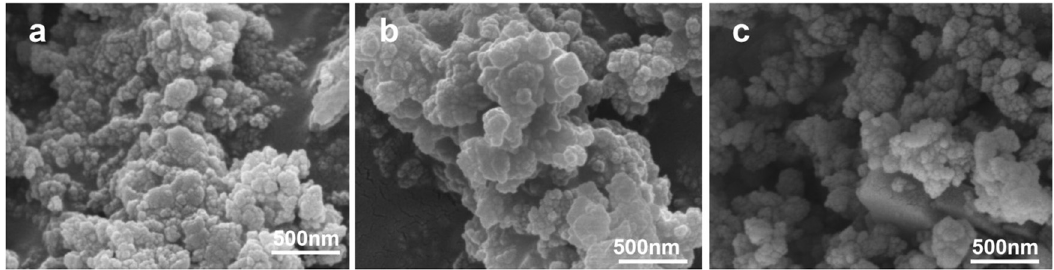
Figure 2: SEM of AlCl 3 /H β catalysts prepared with di ff erent concentrations of AlCl 3 : ( a ) AlCl 3 ( 1 g · L − 1 ) /H β , ( b ) AlCl 3 ( 3 g · L − 1 ) /H β , and ( c ) AlCl ( 5 g · L − 1 ) /H β . 3